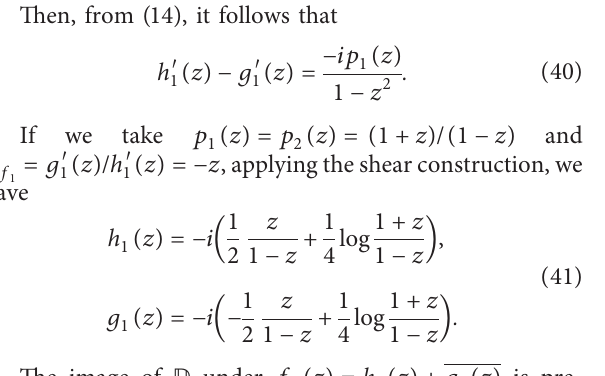
, f , and f . (a) f 1 2